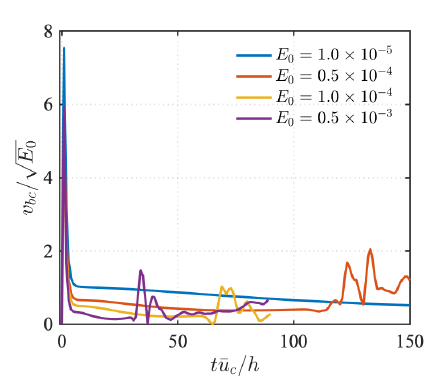
Figure 17. Time history of normalized wall-normal velocity v bc / √ E 0 at the lower wall of case ( α , β ) = ( 0,2 ) when actuation is turned